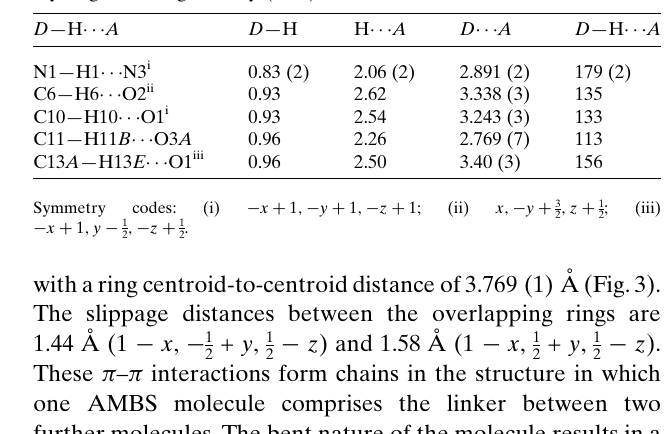
Figure 1 The molecular structure of the title compound with atom labels and 50% probability atomic displacement